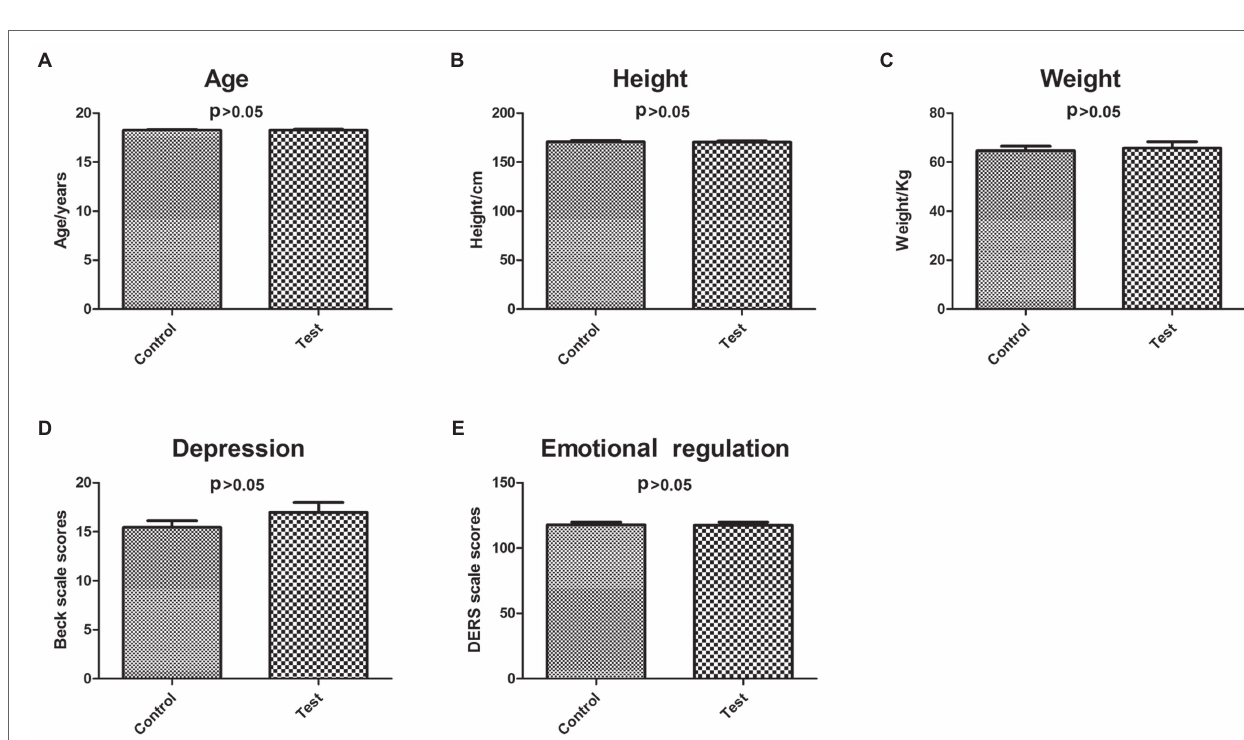
FIGURE 1 | The data collection procedure. GIMT was applied to improve college students’ emotional regulation and depressive symptoms. The specific scheme was depicted in the figure.